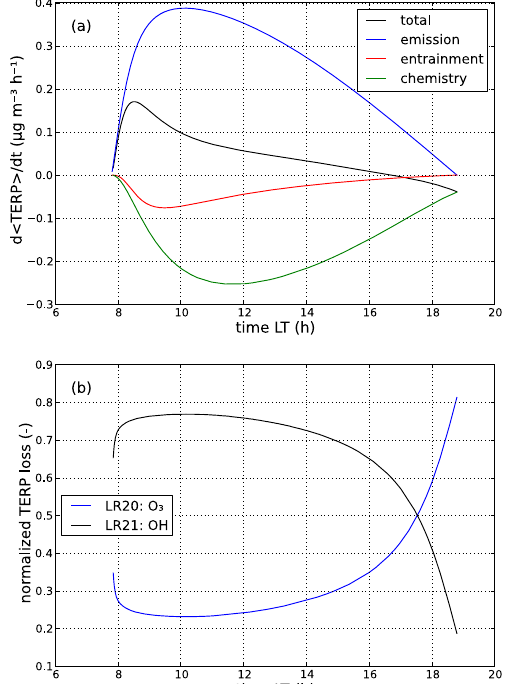
Fig. 7. Contribution of the individual processes to the terpene ten- dency (Eq. 3) for the case study. (a) total tendency and the indi- vidual contributions of emission, entrainment and chemistry, and (b) the normalized contributions to the chemical terpene loss for the reactions with O 3 and